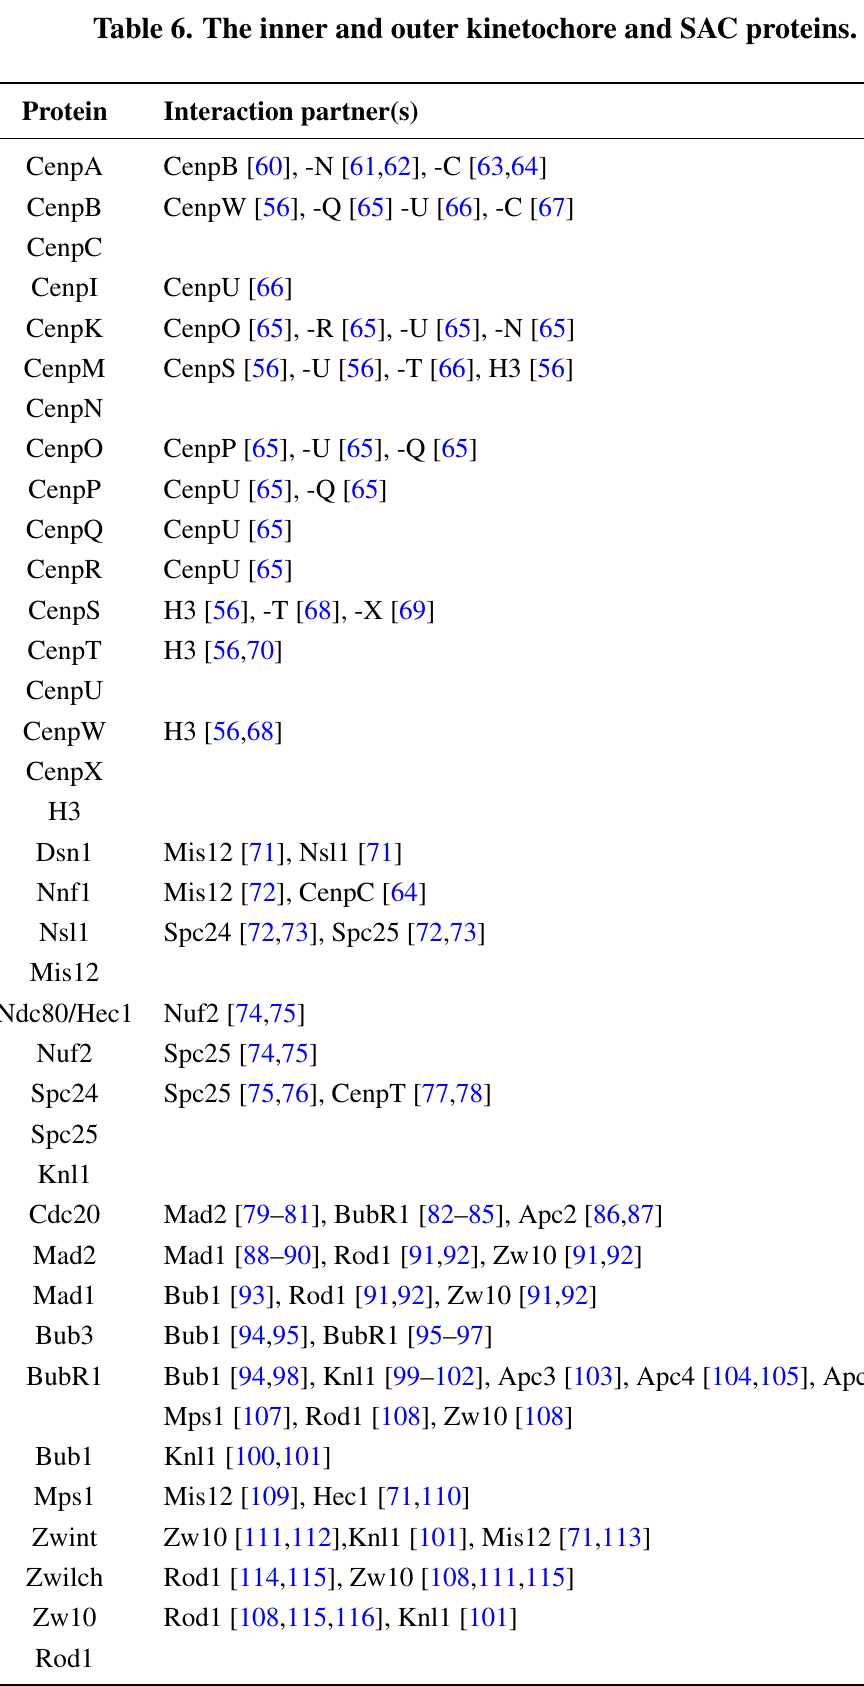
Table 6. The inner and outer kinetochore and SAC proteins.